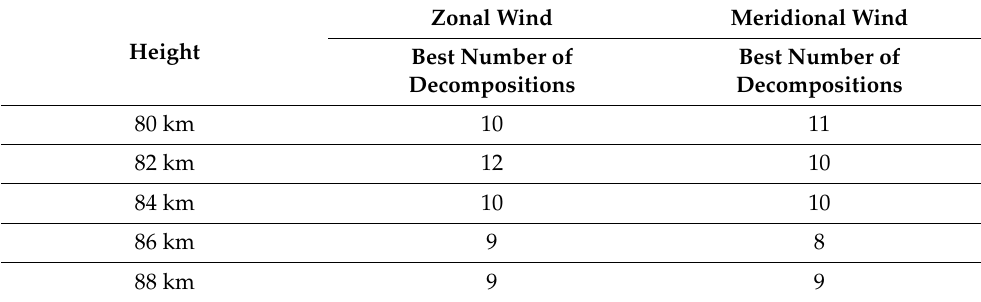
Table 3. Best number of decompositions for 80–88 km meridional and zonal wind sequences. Zonal Wind Meridional Wind Height Best Number of Best Number of Decompositions